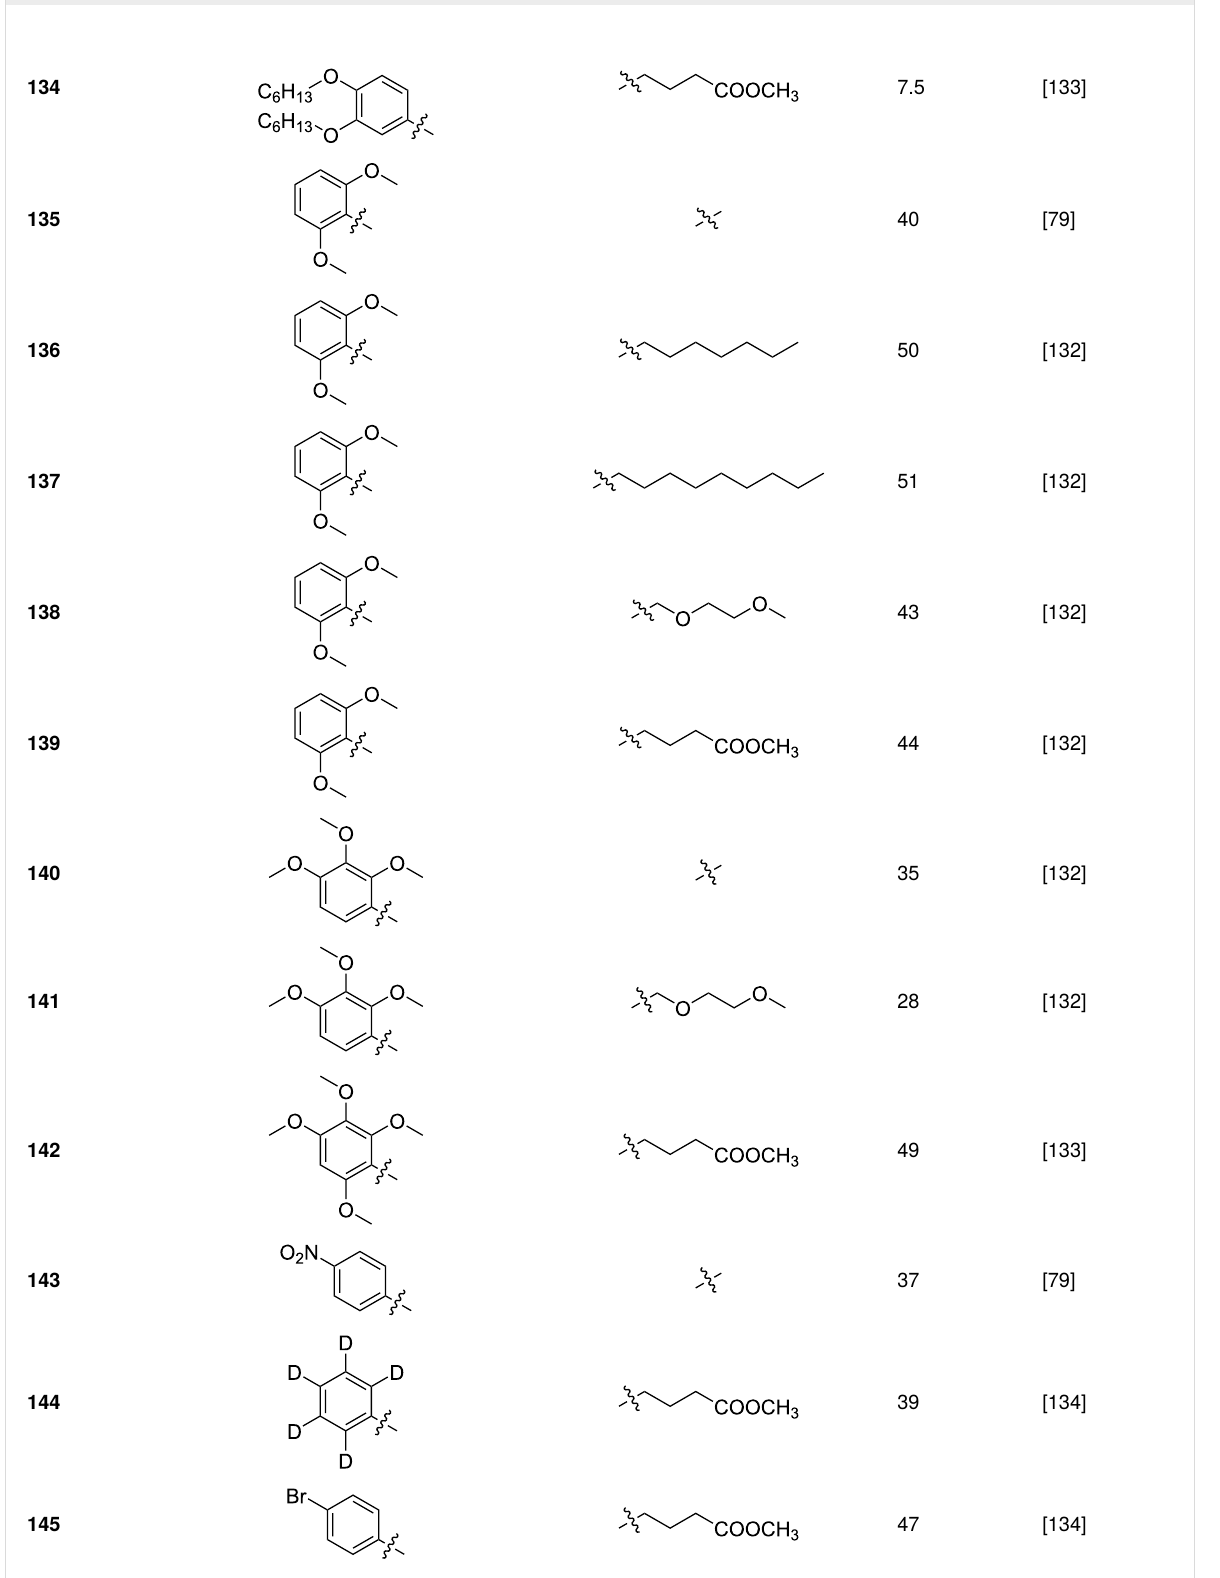
Table 1: [60]PCBM derivatives containing various aromatic and alkyl groups bound to the C 60 core.